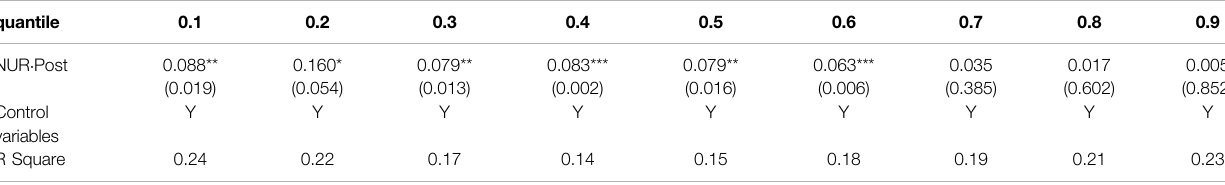
TABLE 3 | The Quantile DID results for the air quality. quantile